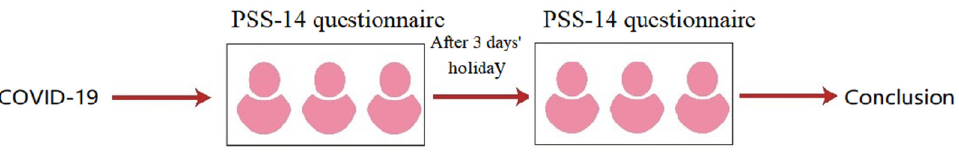
Figure 1. During the period of COVID-19 epidemic, two stress surveys were conducted for medical students. PSS-14 ques-tionnaire was used for the two surveys, with a 3-day vacation interval be- tween the two